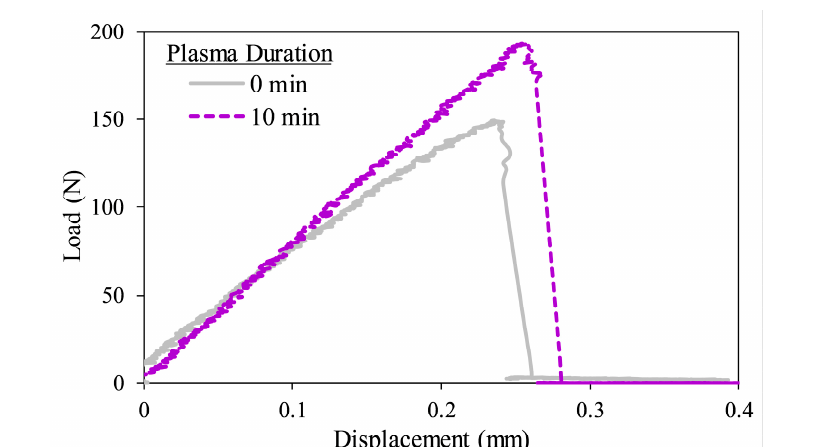
Figure 6. Load-displacement curves from lap-shear testing for representative pCD-coated samples of untreated and plasma-treated PP substrates.